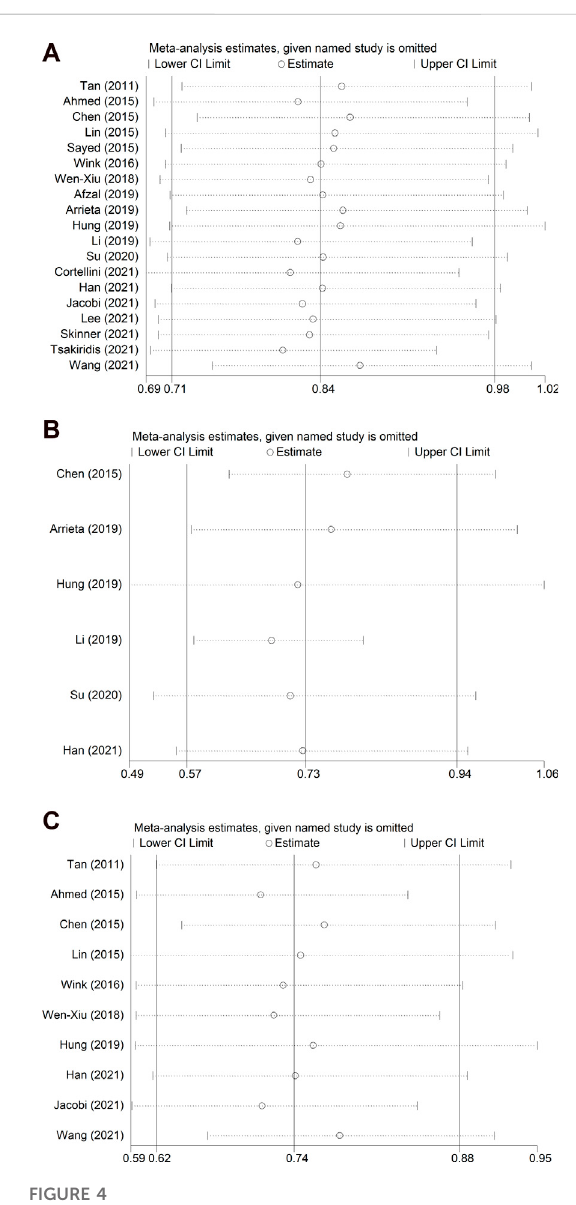
and overall survival in (A) all NSCLC patients; (B) patients receiving EGFR-TKI therapy; and (C) patients with diabetes mellitus. NSCLC: non-small cell lung cancer; EGFR-TKI: epidermal growth factor receptor-tyrosine kinase inhibitor.